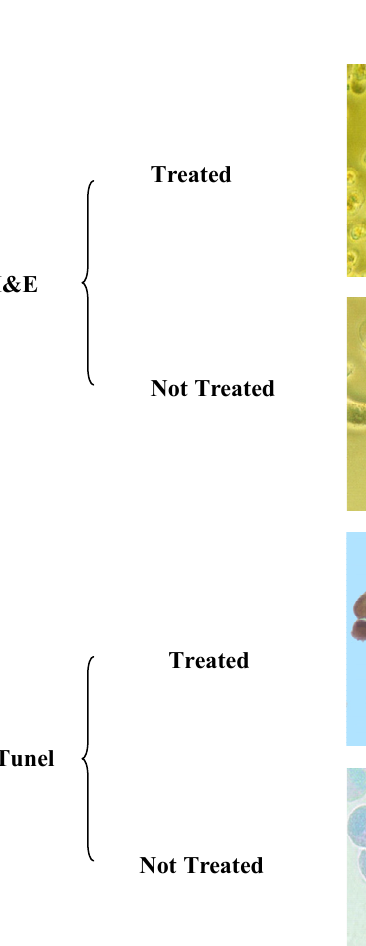
Figure 4. Apoptosis induced by C595-AC for pancreatic cancer cell lines